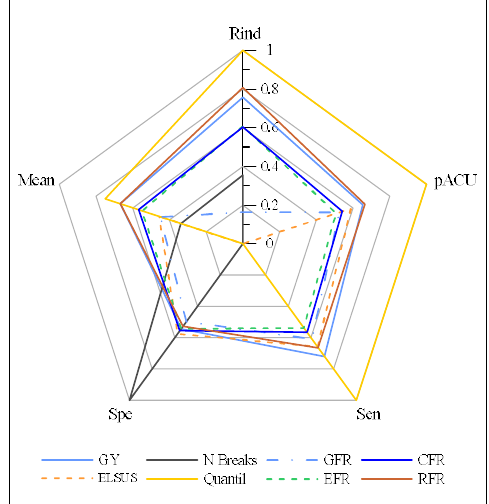
Figure 7. Radial plot of data from Table 11.